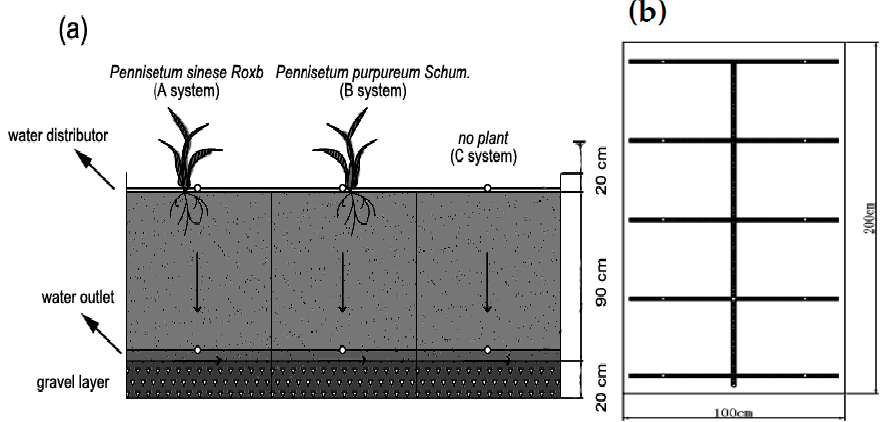
Figure 1. Schematic diagram of the simulate vertical flow constructed wetland ( a ) and plane figure ( b ).